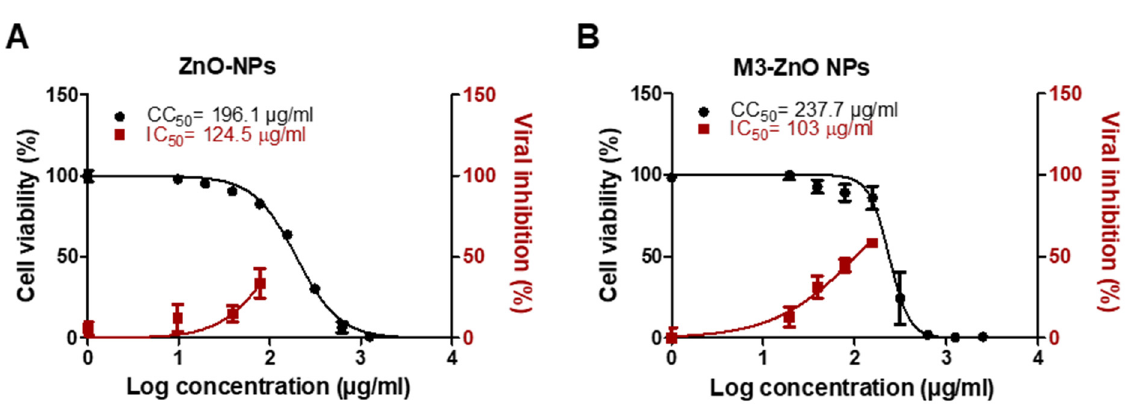
Figure 18. In vitro antiviral activity of ( A ) drug-free ZnO NPs compared to ( B ) M3 -loaded ZnO NPs. The antiviral activity was assessed using NRC-03-nhCoV strain (Accession # EPI_ISL_430820) co-cultured with Vero-E6 cells. IC 50 and CC 50 on viral and Vero cells were calculated using nonlinear regression analysis by plotting log inhibitor concentration versus normalized response (variable slope). The data display the mean of cell viability percentage ± SEM of 4 replicas.